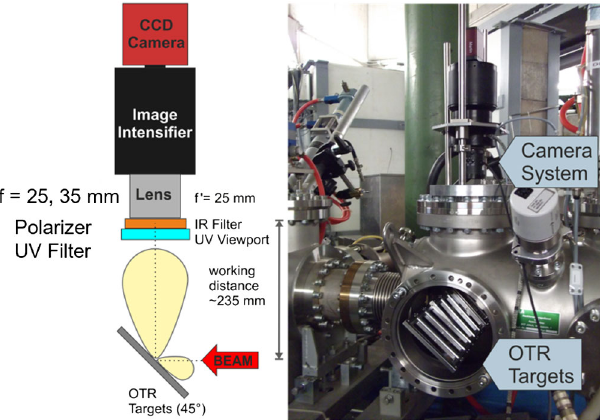
FIG. 4. The experimental setup showing the OTR target ladder mounted with several OTR targets and the optical system